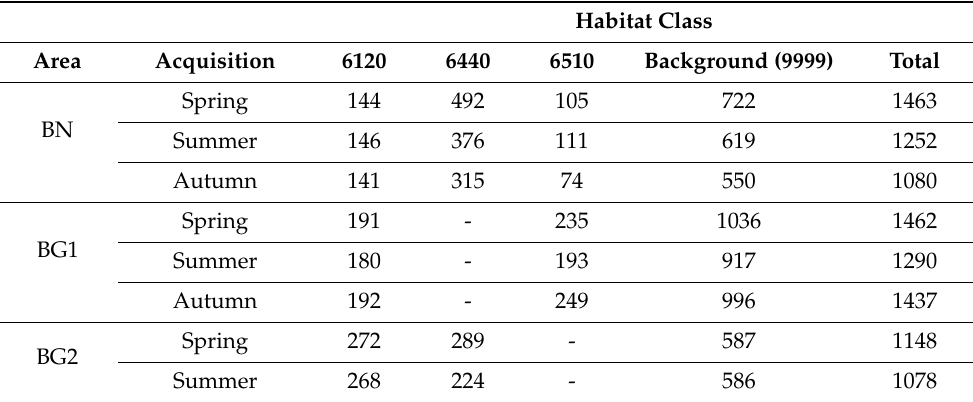
Table 1. Number of reference polygons for each habitat class and study